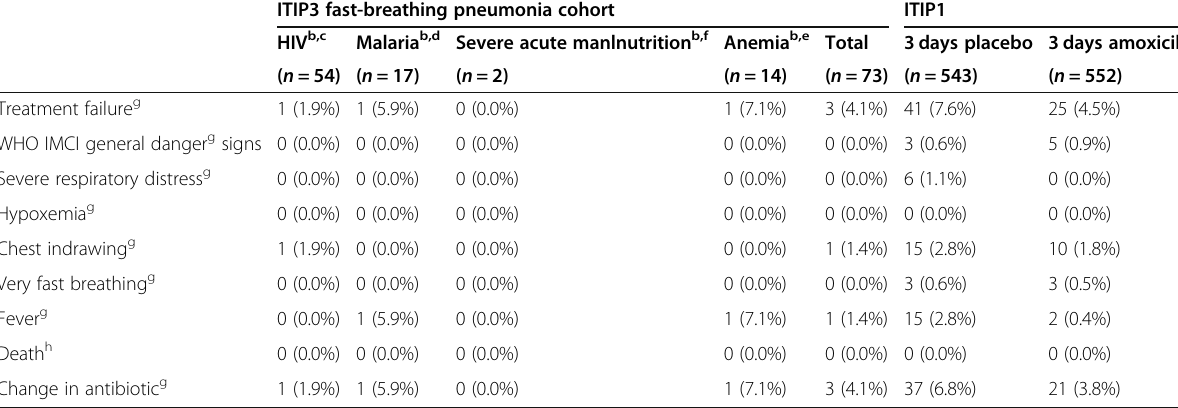
Table 3 ITIP3 fast-breathing pneumonia cohort and ITIP1 treatment failure rates a ITIP3 fast-breathing pneumonia cohort